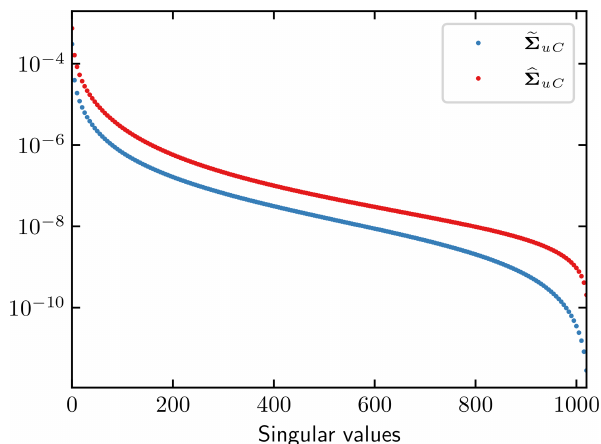
Figure 15. The singular values of the transfer matrices of SSA with simplifications from MacAyeal (1993). (cid:101) (cid:54) uC corresponds to the for- ward viscosity case and (cid:98) (cid:54) uC is from the adjoint SSA without cou- pling to the ψ